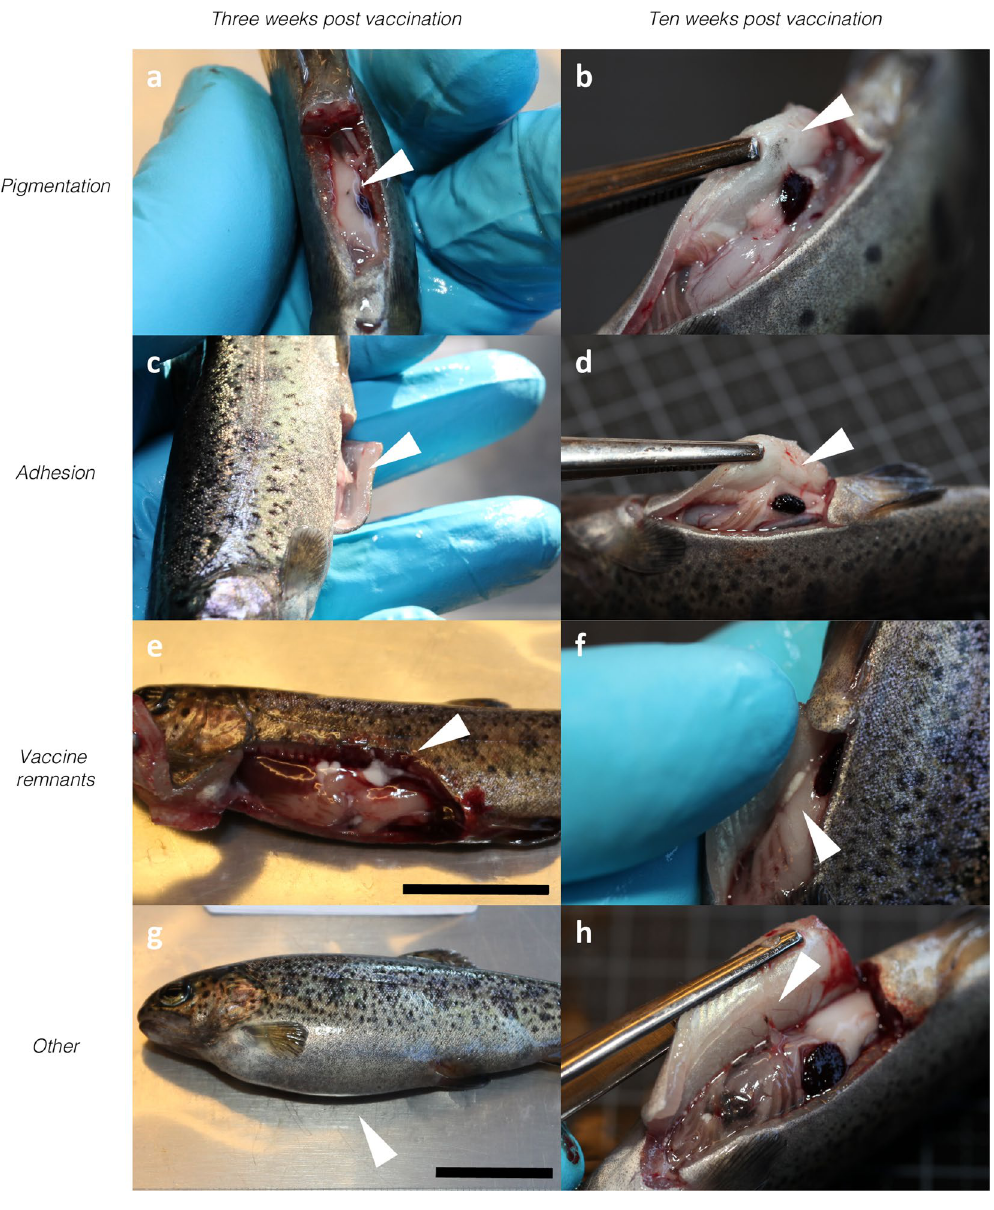
Figure 3. Representative macroscopic observations made during post-mortem examination of vaccinated individuals at three and ten weeks post vaccination, shown on the left ( a , c , e and g ) and right hand side ( b , d , f and h ), respectively. Arrowheads indicate each observation. A) Focal pigmentation of intraperitoneal adipose tissue, bacterin group. ( b ) Diffuse pigmentation of abdominal viscera, CAF01 group. ( c ) Adhesion connecting adipose tissue to injection site, CAF01 group. ( d ) Adhesion connecting adipose tissue to injection site, CPG group. ( e ) Remnants of FIA emulsion in peritoneal cavity, FIA group. ( f ) Remnants of FIA emulsion in peritoneal cavity, FIA group. ( g ) Abdominal distension, CpG group. ( h ) Pigmentation near injection site, adhesion connecting viscera to injection site, remnants of FIA emulsion scattered in peritoneal cavity, FIA group. Scale bars measure 2